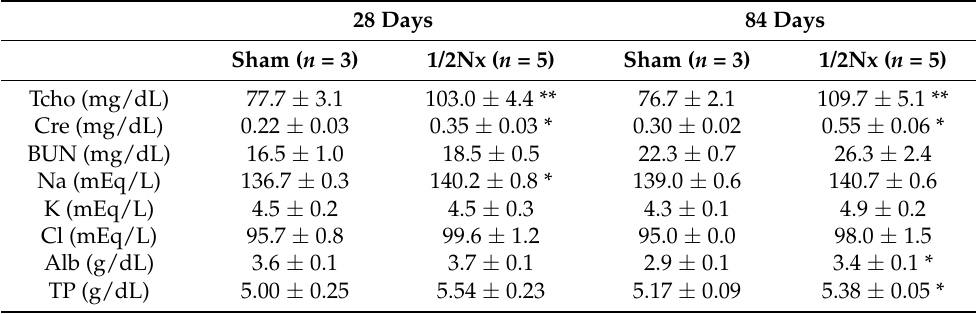
Table 3. Biochemical parameters in plasma of Sham operated and 1/2Nx DEK